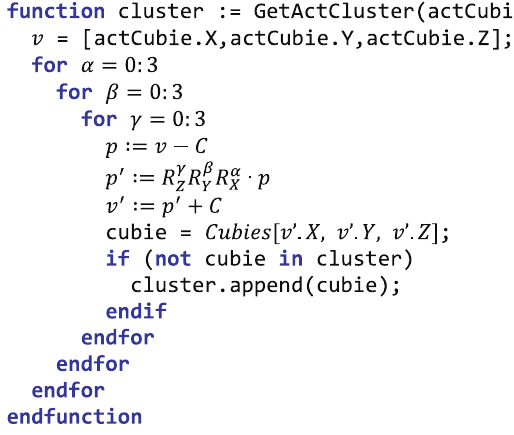
Figure 7: Implementation of function retrieving actual cluster (containing active cubie) (pseudocode).